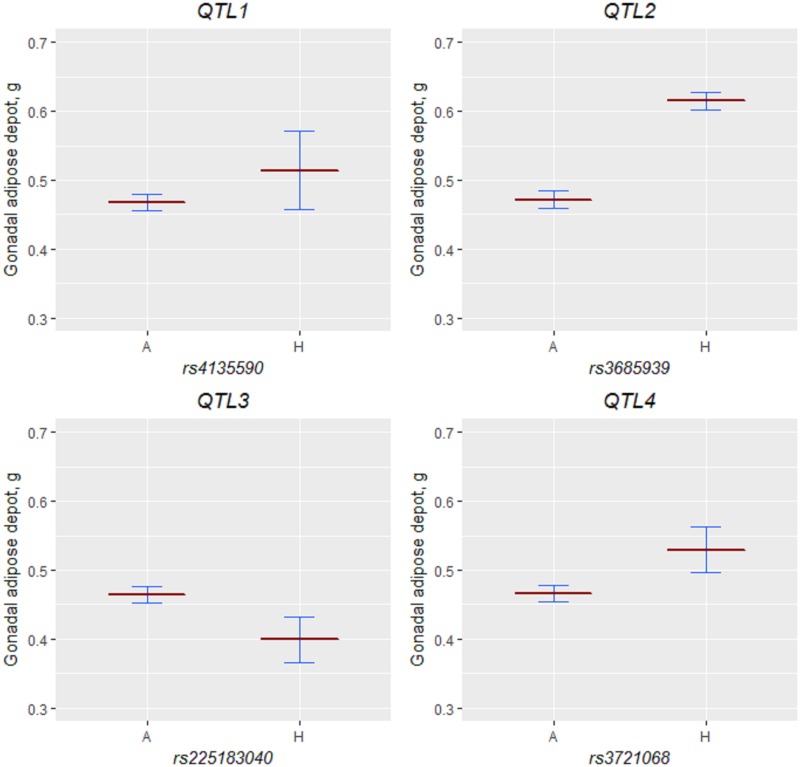
QTL effects.The least square means (dark red lines) and 95% lower and upper confidence limits (blue lines) for QTL genotypes were obtained from the general linear model with body weight as covariate in the congenic mouse data used for the sequential analyses. We selected one marker in the middle of each QTL to plot each QTL effect. The host (A) comprised littermates homozygous for B6/B6 from all strains; we selected appropriate congenic mice (H) as suggested by the results of the sequential analysis.